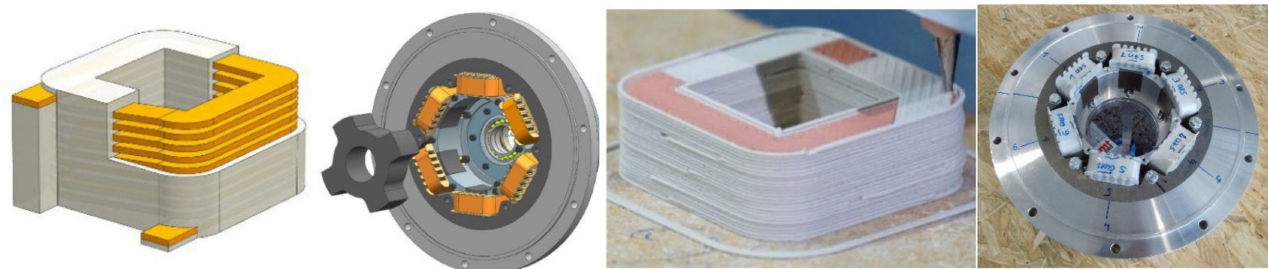
Figure 16. Prototyping of a 6/4 switched reluctance machines (SRM) using AM multi-material coils of copper and ceramics [67].